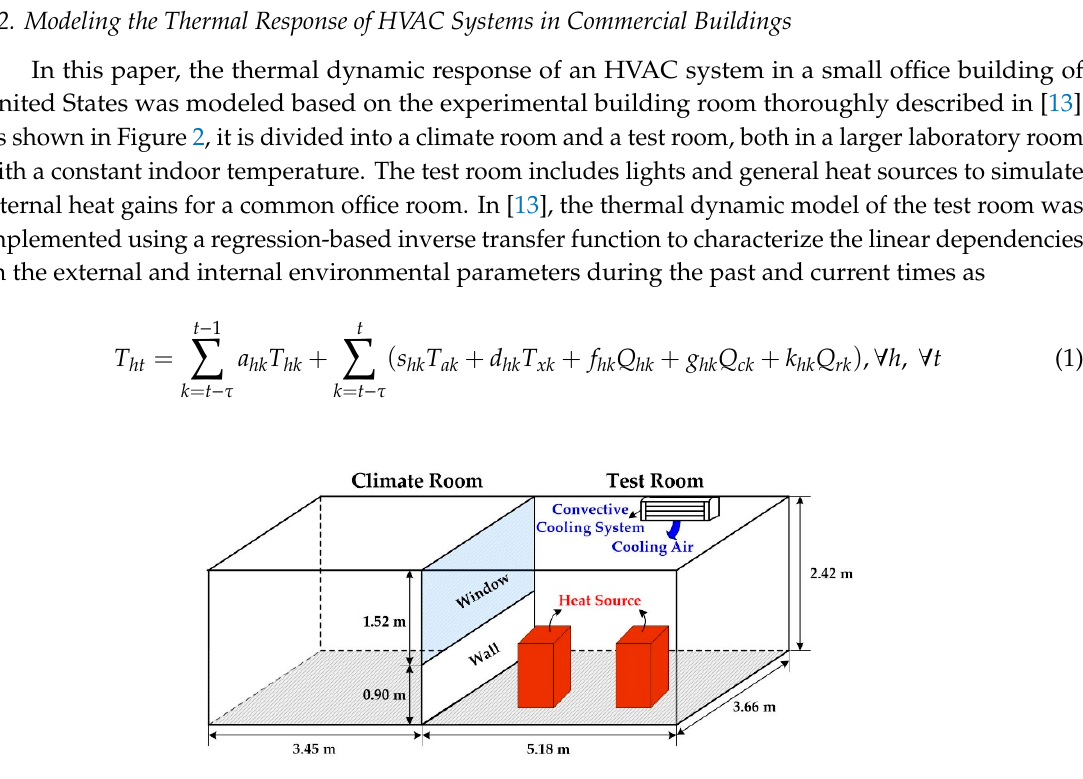
Figure 2. Experimental room setup for estimating the thermal dynamic response to the input power of an HVAC system. Table 1. Coefficients for the inverse transfer function (ITF) model (1) that were experimentally obtained in [28].